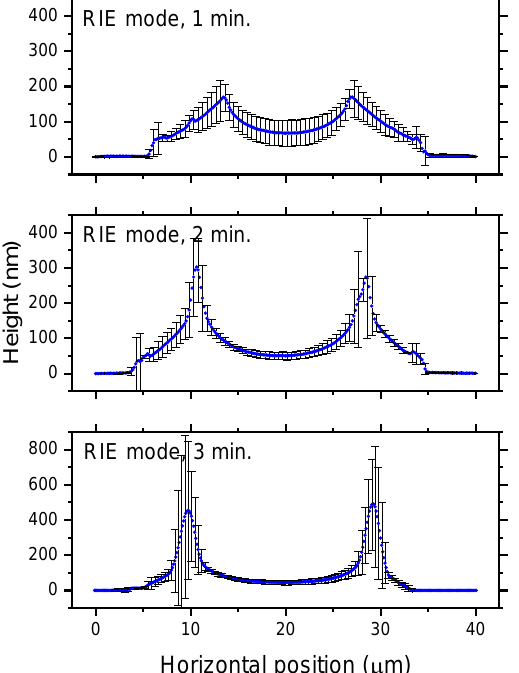
Figure 6. Height profiles of the patterned PEDOT:PSS lines made by plasma-treating the photoresist in reactive-ion etching (RIE) mode before spin-coating PEDOT:PSS. The error bars show the maximum and minimum values at each position.